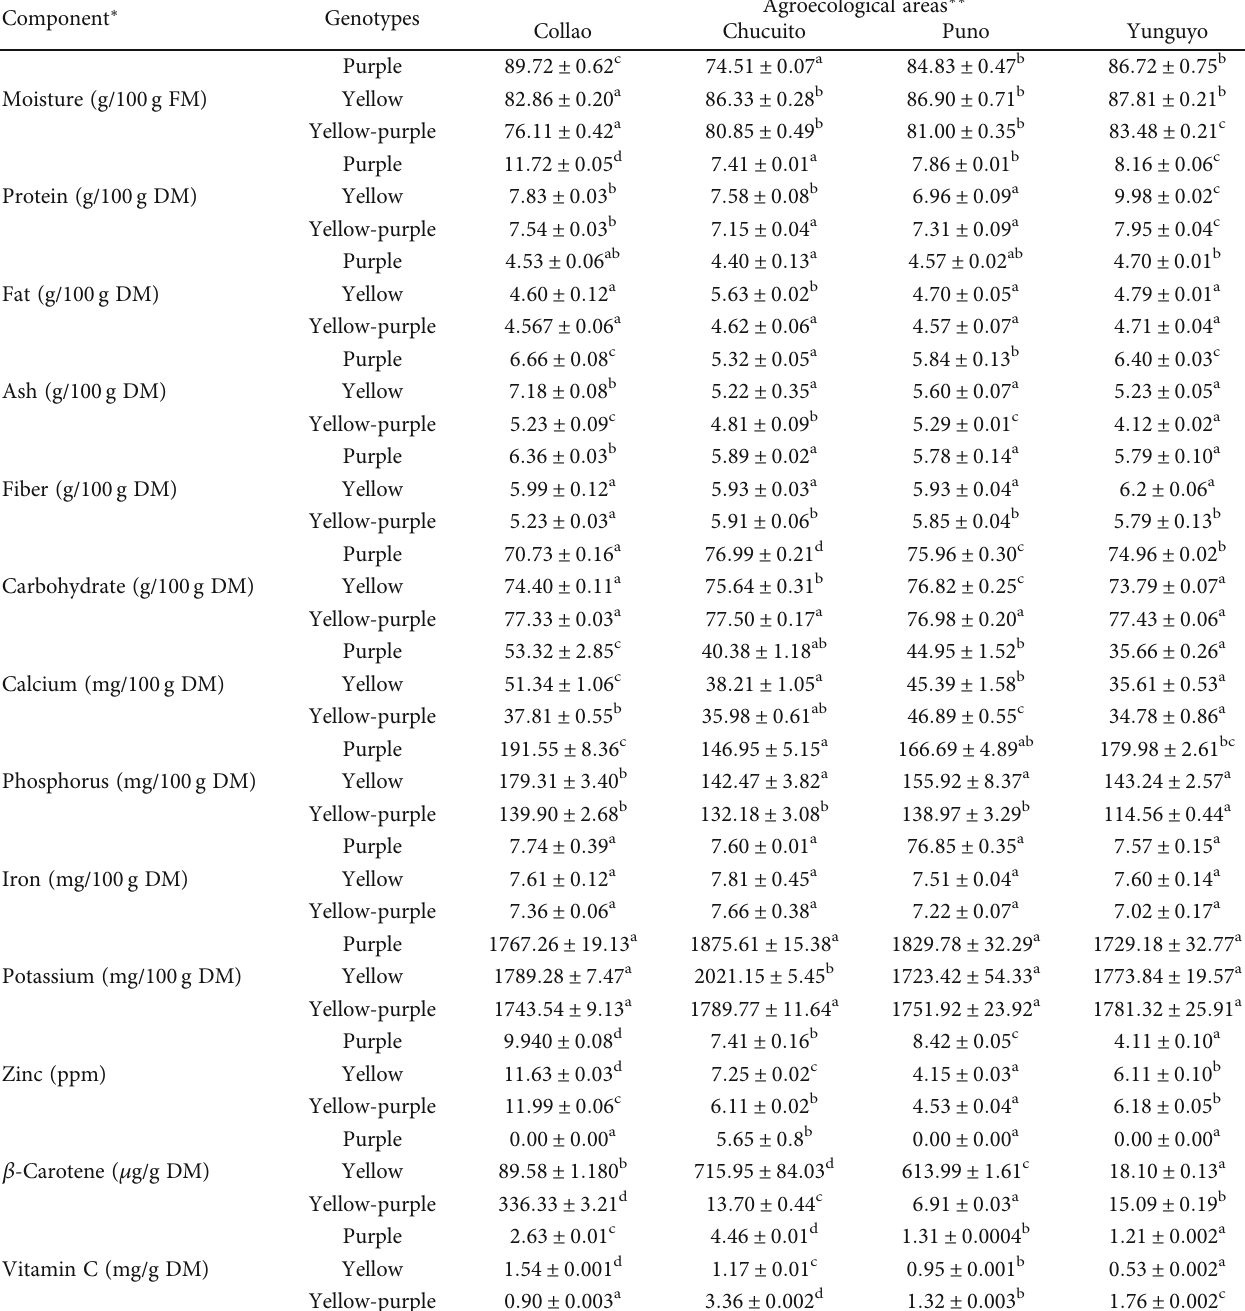
Table 1: Physicochemical characterization of three genotypes of mashua from di ff erent agroecological areas. Component